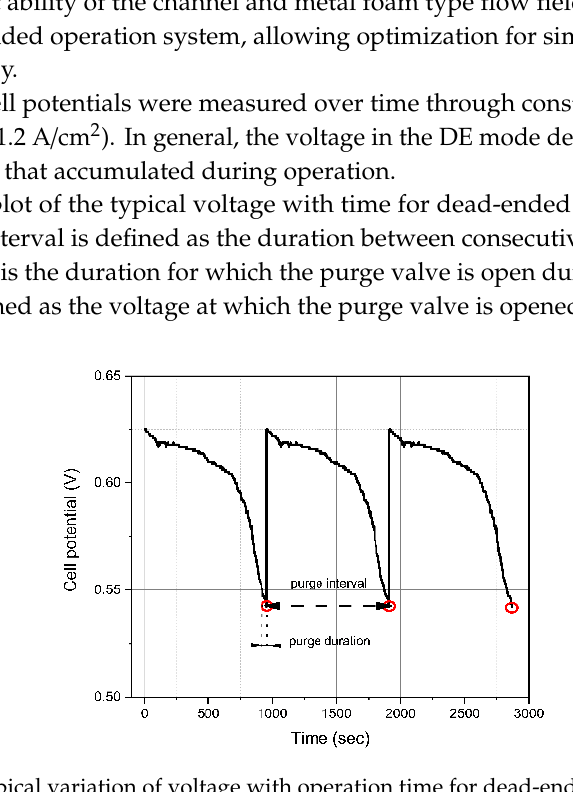
Figure 5. Typical variation of voltage with operation time for dead-ended operation.